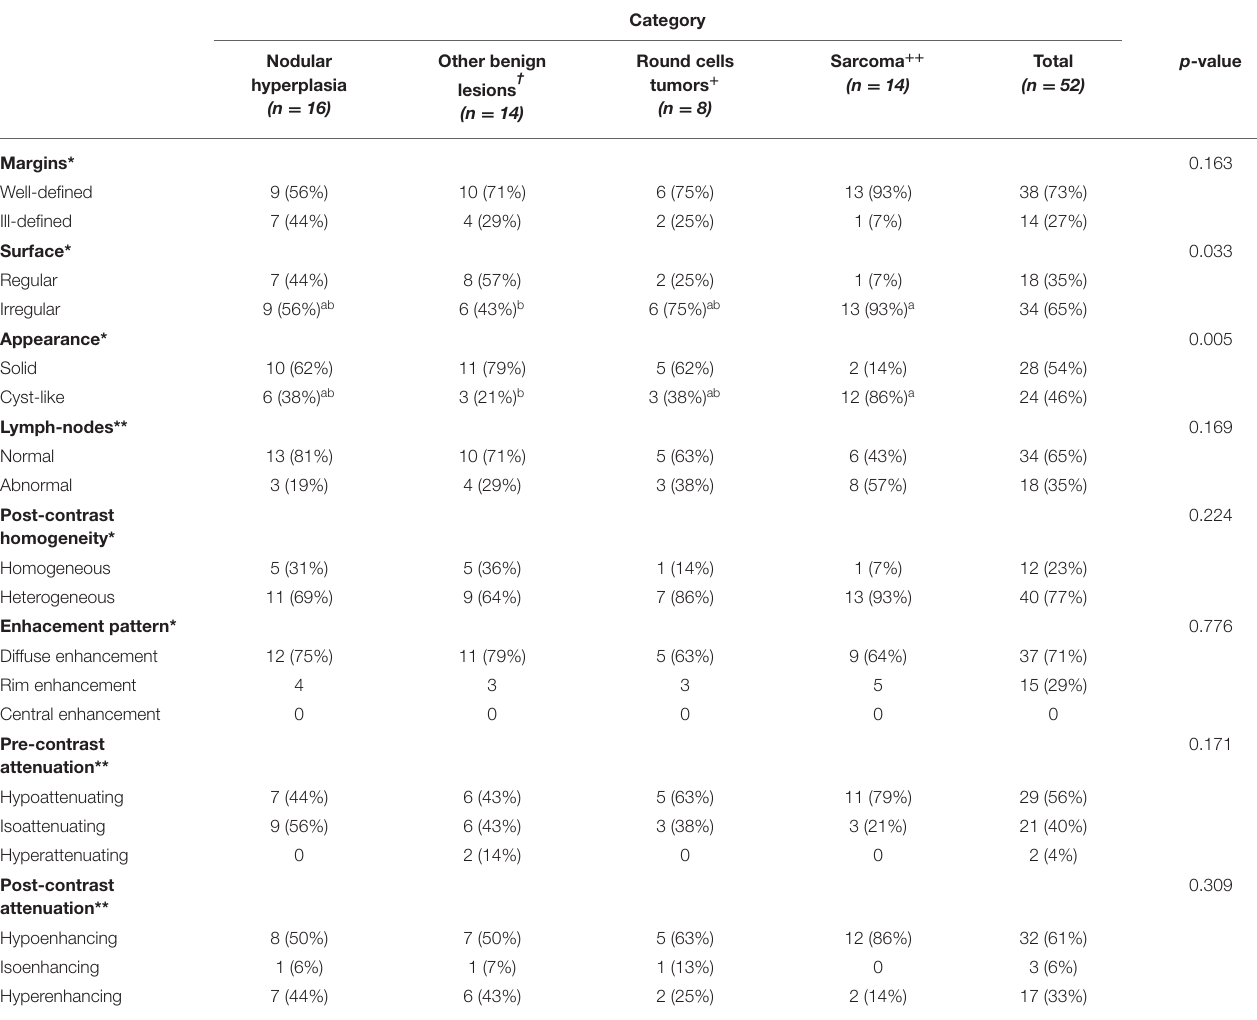
TABLE 1 | Qualitative features, along with cytological or histological